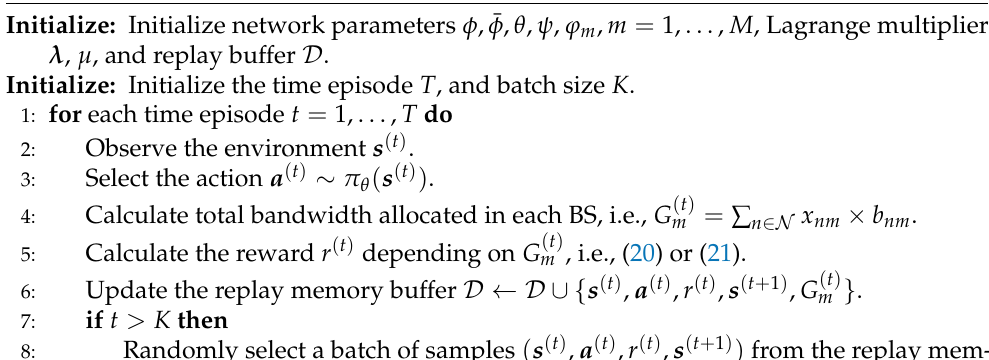
Algorithm 1 Augmented Lagrangian-based soft actor–critic